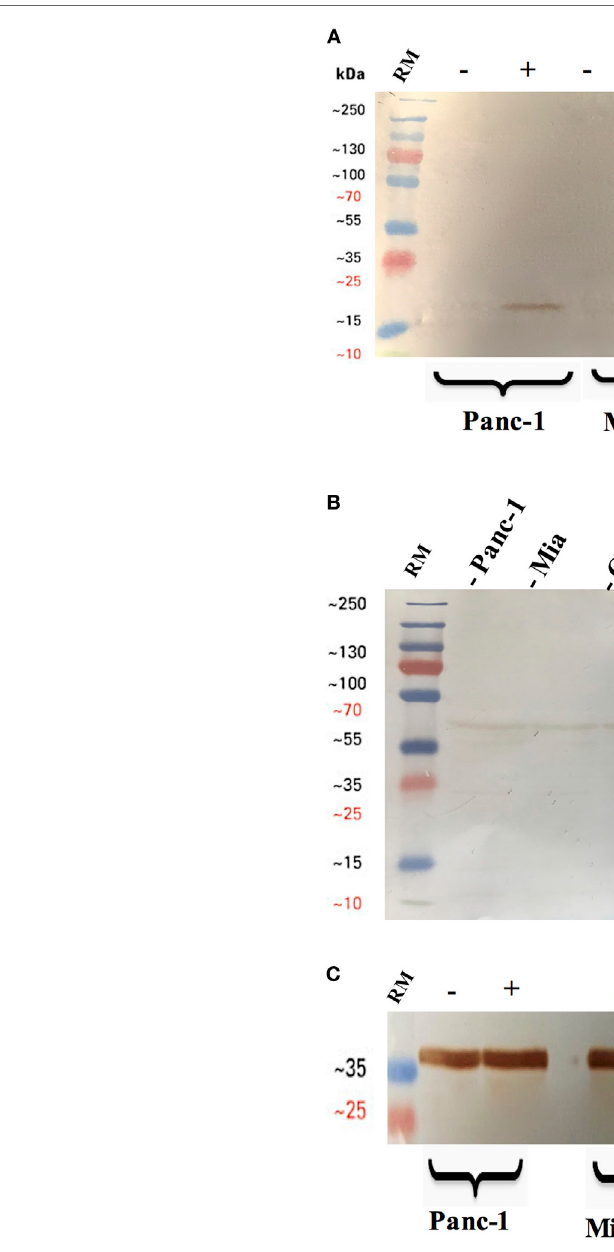
FigUre 4 | Cleavage of caspase 3 (a) and 8 (b) in pancreatic cancer cell lines following rfhSP-D treatment. Pancreatic cancer cell lines were analyzed for caspase 8 and 3 activation via western blot using anti-rabbit cleaved caspase 3 and 8 (1:1,000) at 4°C overnight, followed by incubation with secondary anti-rabbit IgG HRP-conjugate (1:1,000) for 1 h at room temperature. The membrane was washed with PBST (PBS + 0.05% Tween 20) three times, 10 min each between each step. The bands were developed using 3,3 ′ -diaminobenzidine substrate kit. The cleaved caspase 3 and 8 were detected only in the rfhSP-D treated samples of all cell lines, whereas no bands appeared in the untreated cell samples. Full-length caspase 8 bands are visible around 43 kDa. (c) Anti-GAPDH was used as a loading